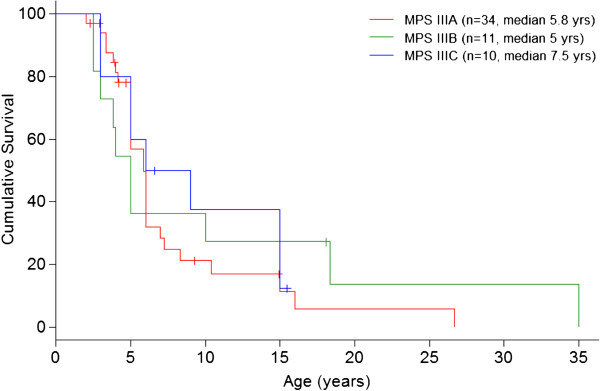
Age of speech loss.